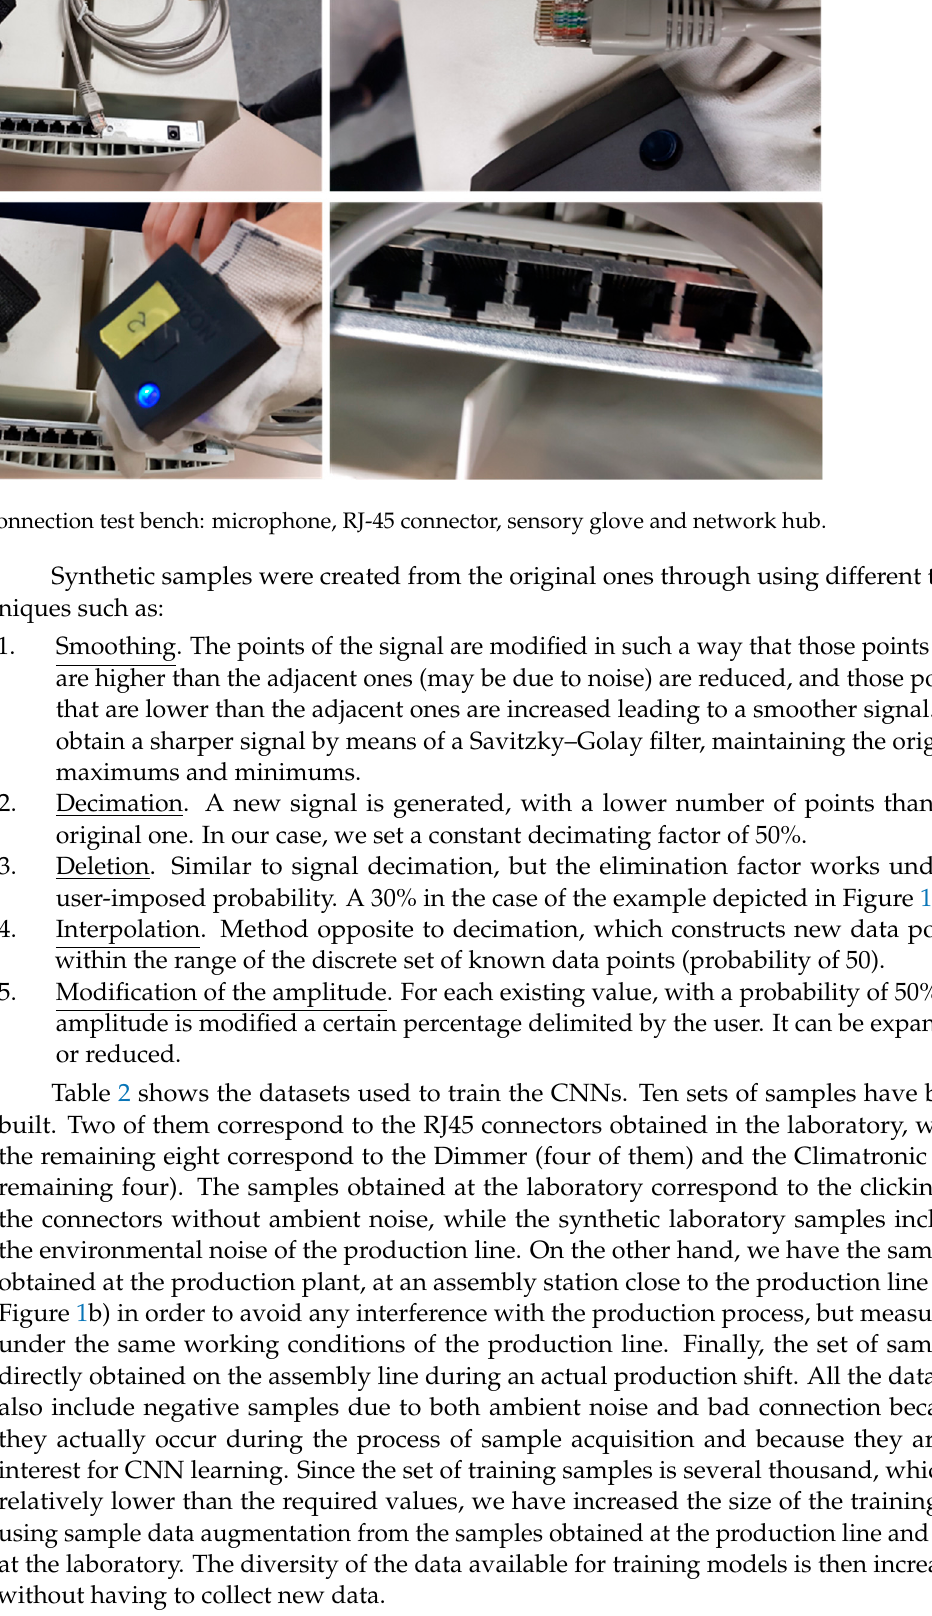
connectors) in many different noise conditions. Environmental noise previously recorded